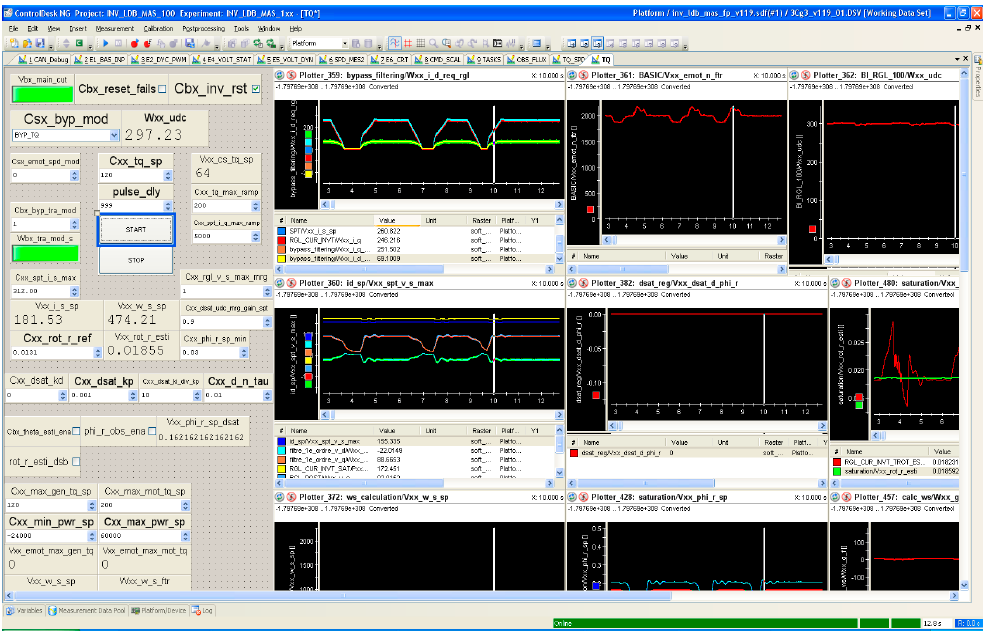
Figure 4. Interface of rapid control prototyping in real-time at the test-bench.